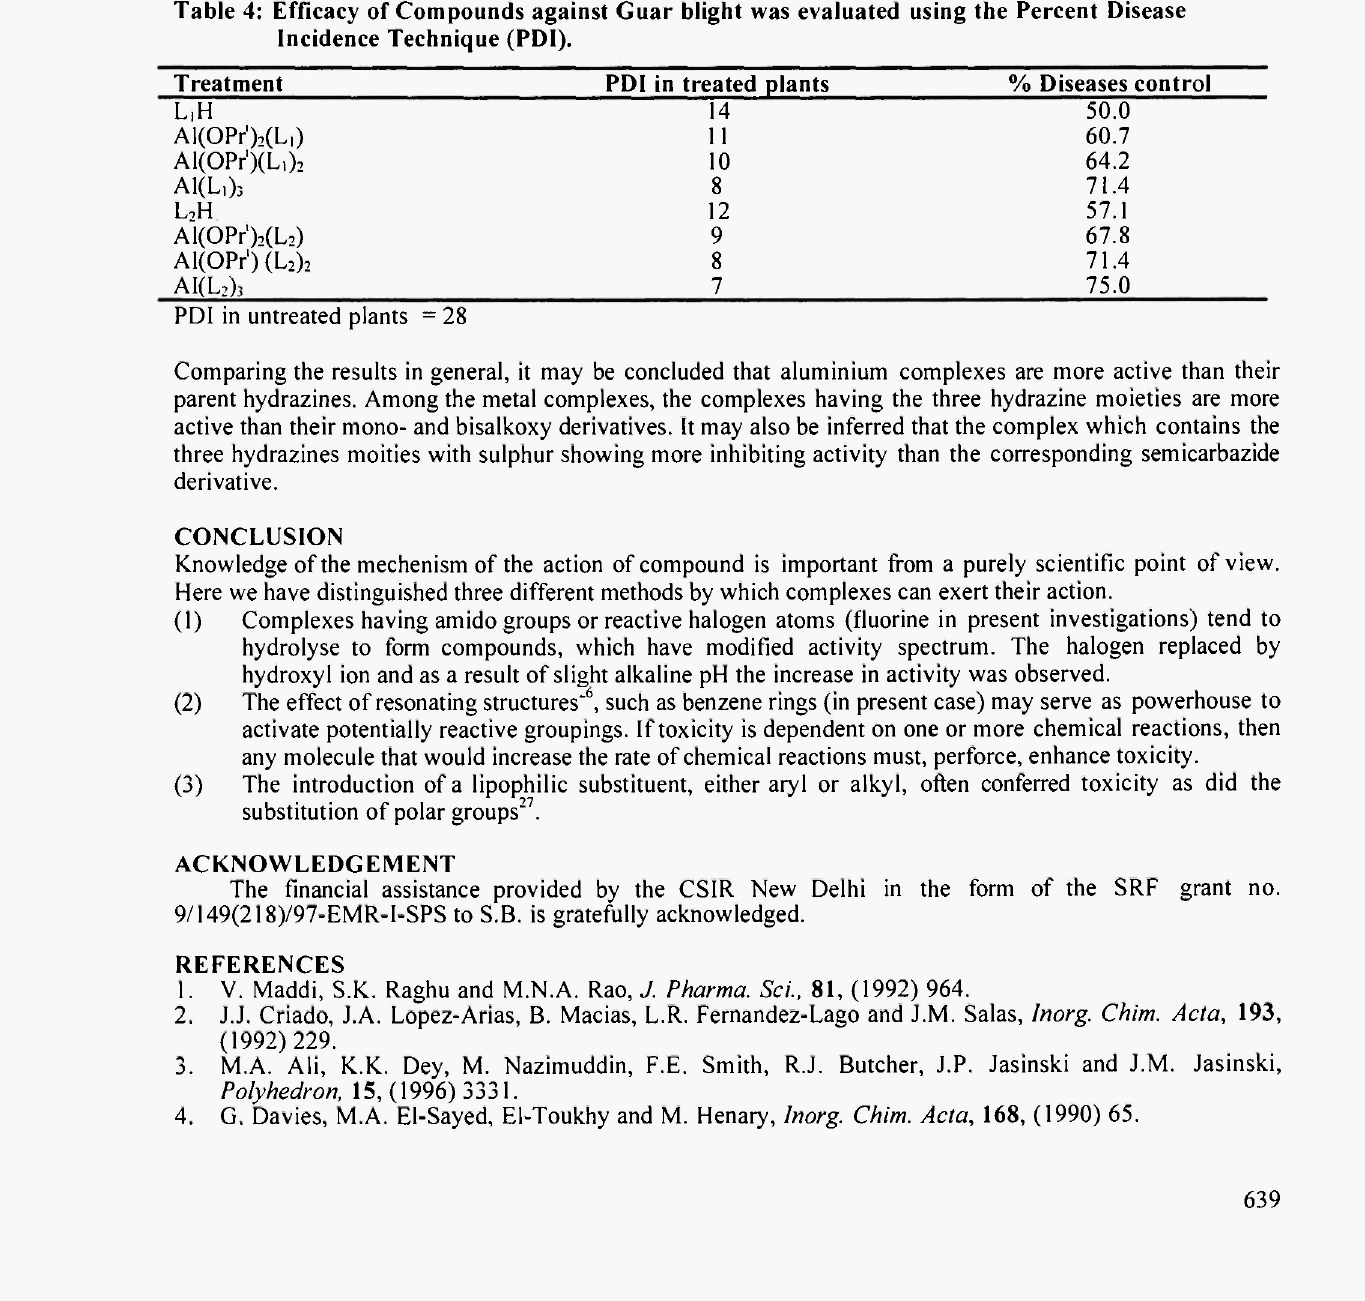
Table 4: Efficacy of Compounds against Guar blight was evaluated using the Percent Disease Incidence Technique